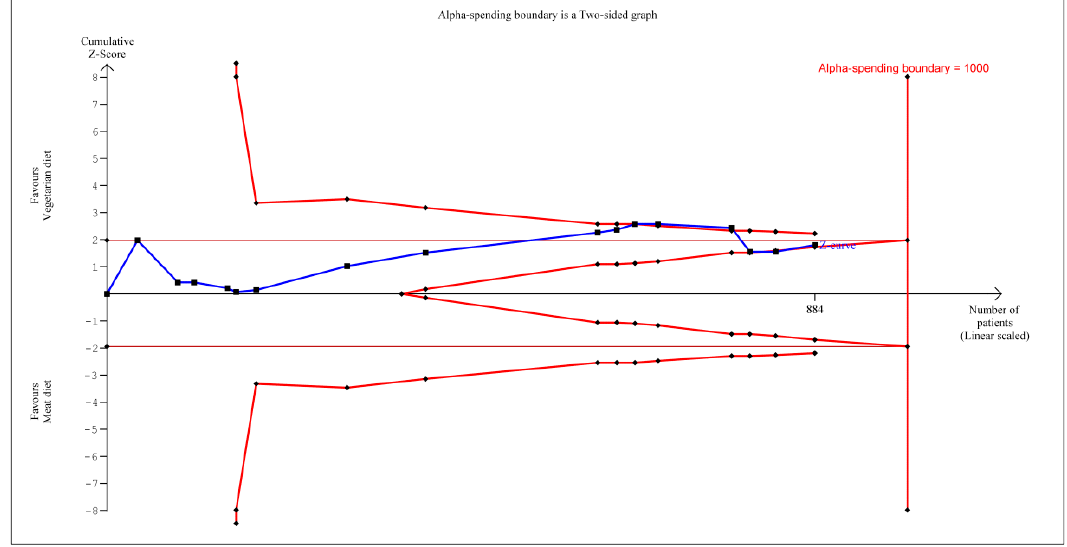
Figure 2. Trial sequential analysis on the effect of vegetarian diets vs. omnivorous diet on systolic blood pressure reduction.